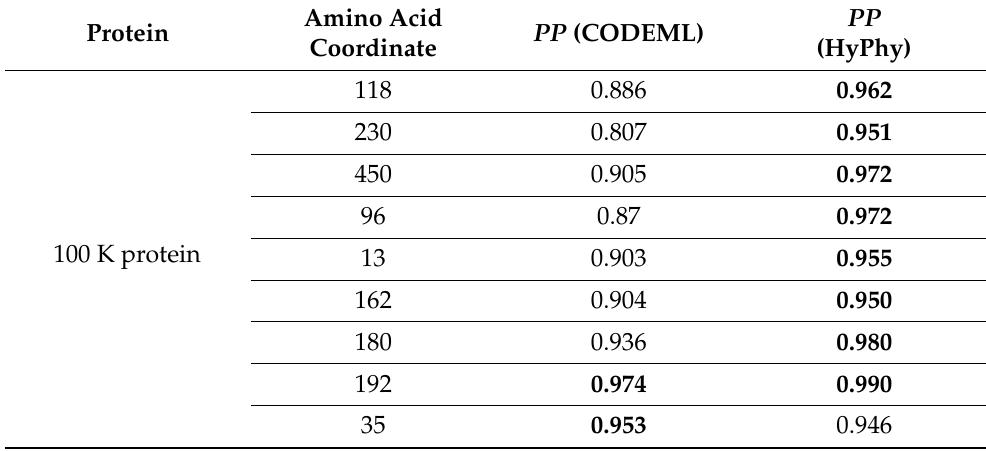
Table 4. Identified the most reliable candidate sites for positive selection. PP values ≥ 0.95 are in